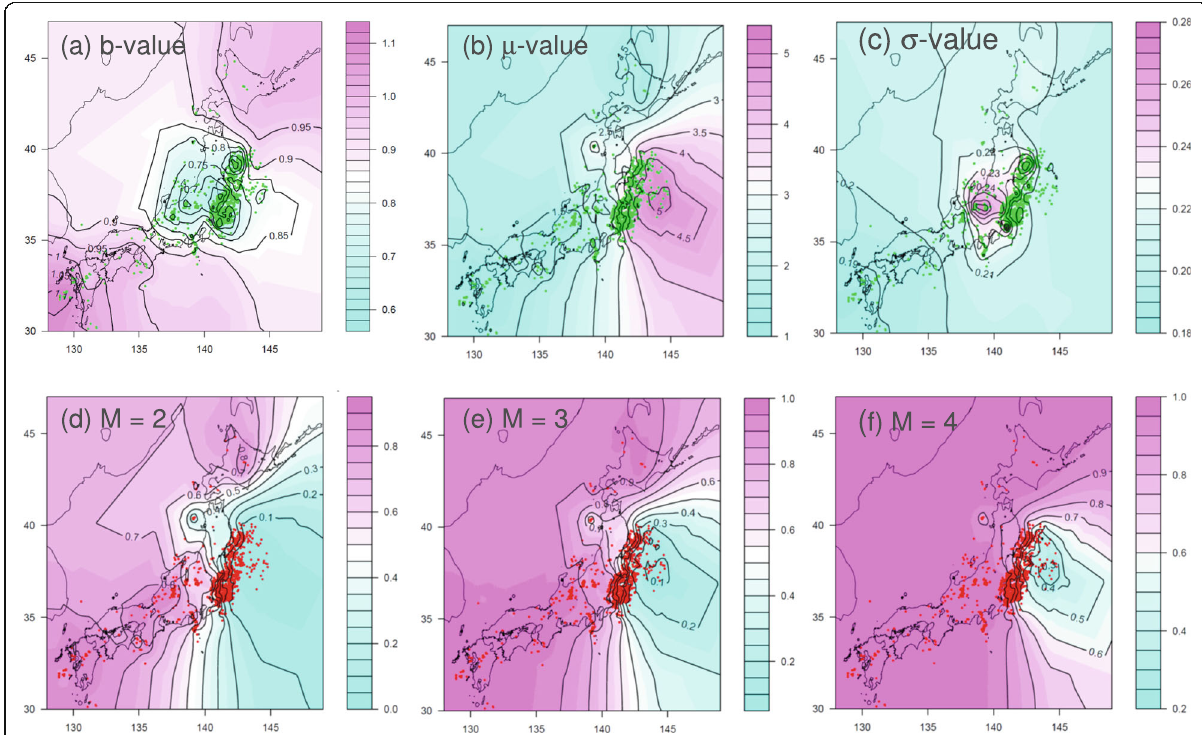
Fig. 11 Examples of spatial detection rate analysis of aftershocks. Estimated surfaces for earthquakes shallower than 65 km detected by the JMA network 1 day after the 2011 M9 Tohoku-Oki earthquake. Earthquakes are shown as green and red dots. a b values with contour interval 0.05, b μ value (magnitude with 50% detection rate) with contour interval 0.05, c σ value with contour interval 0.01, and d – f 97.5% detection rate of M 2.0, M 3.0, and M 4.0 earthquakes, respectively, with contour interval 0.1